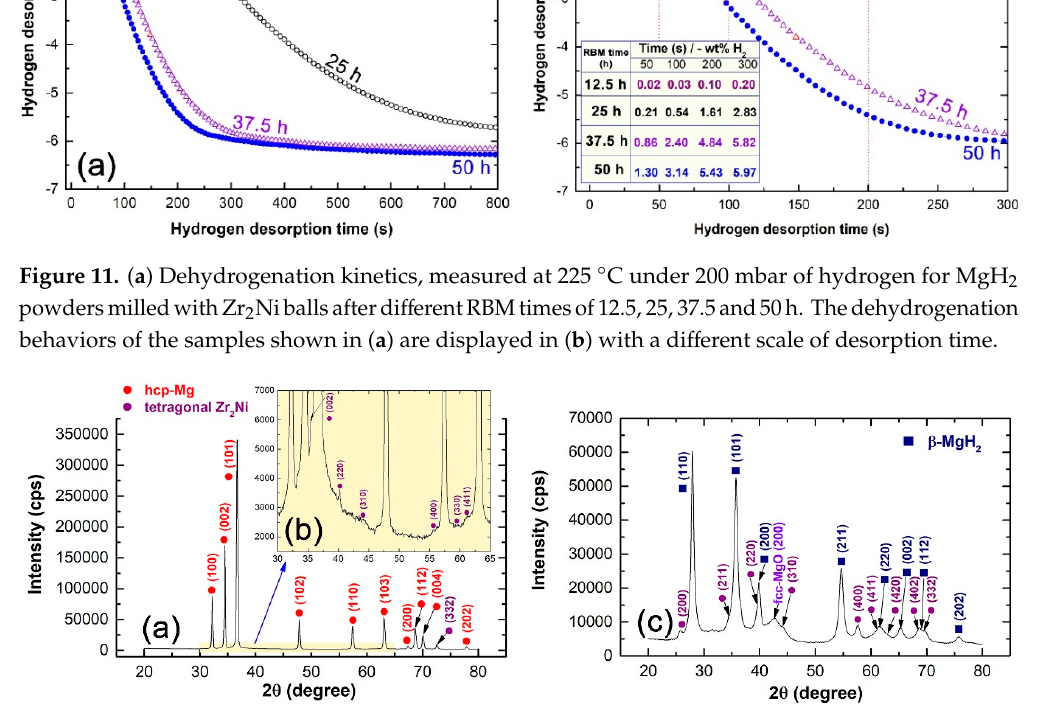
Figure 12. XRD patterns measured with CuK radiation for 50 h ‐ sample taken after ( a , b ) dehydrogenation kinetics, and ( c ) hydrogenation measurements.